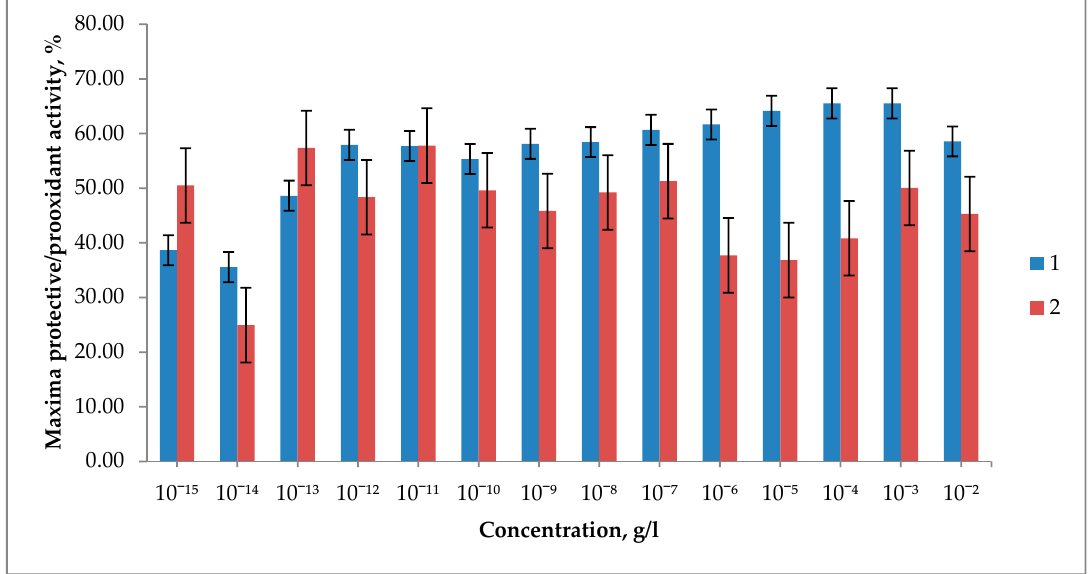
Figure 4. Maximum protective (1) and prooxidant (2) effect of the C 60 solution in TWEEN 80 2% of different concentrations.